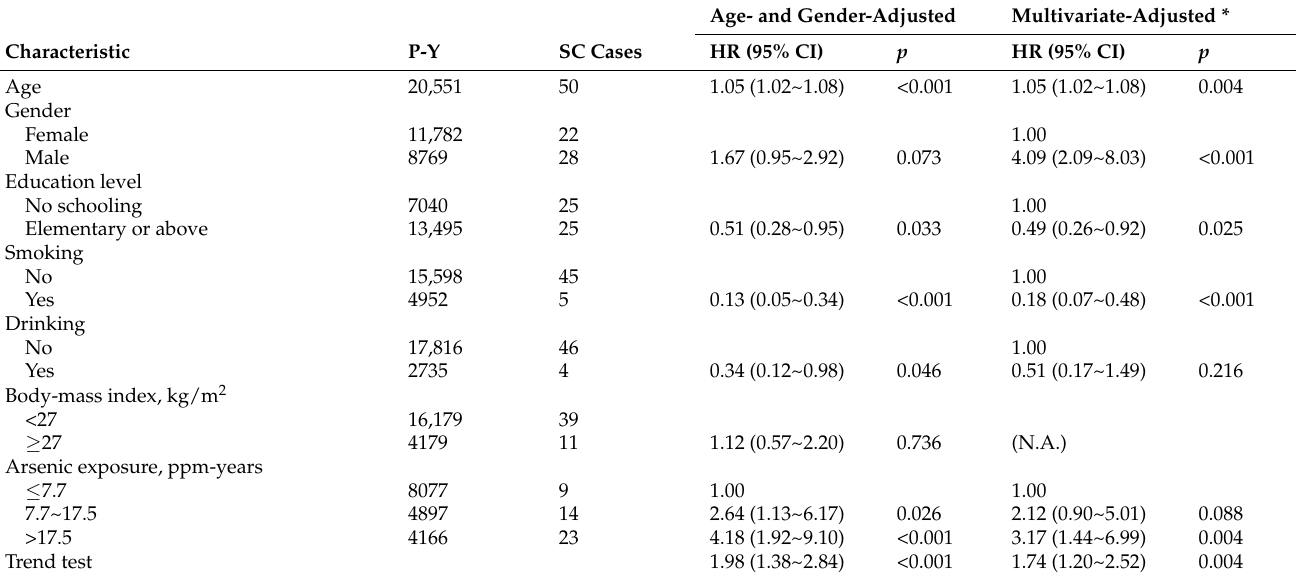
Table 2. Hazard ratios (HRs) of skin cancer in relation to baseline characteristics among the study